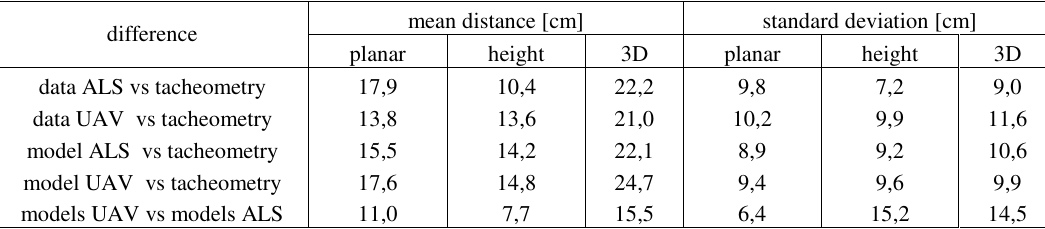
Tab 3.2: Statistics on the absolute accuracy, performed based on the residuals between Check Points.